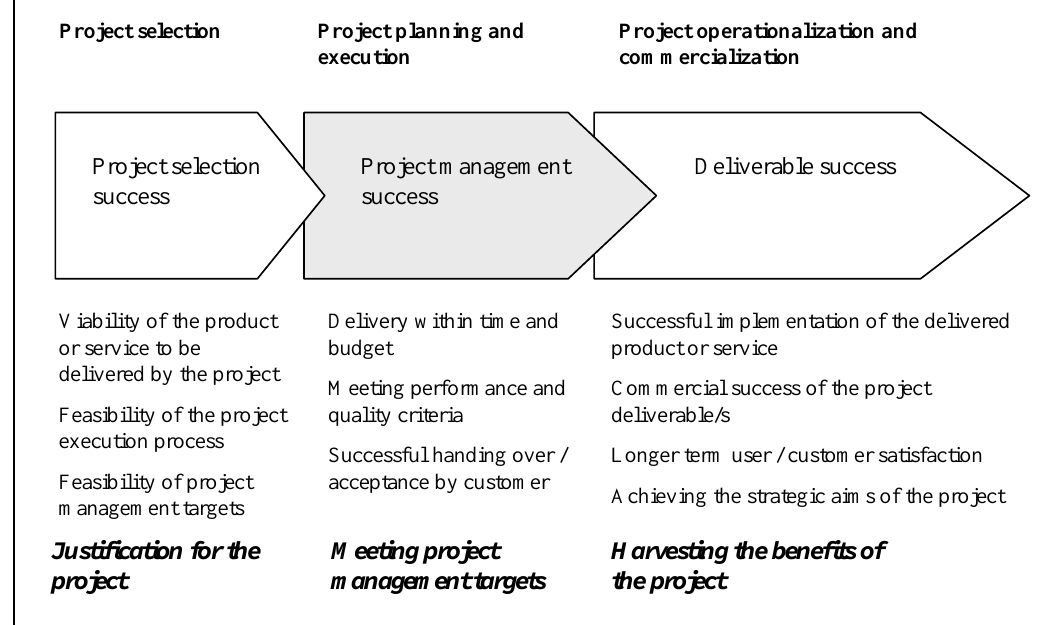
Figure 1: The domains of project success over its life